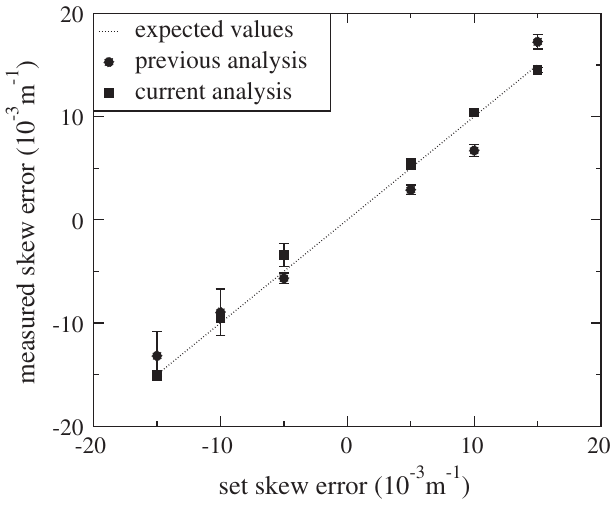
FIG. 14. Skew quadrupole errors estimated from the conven- tional difference orbits (circles) and skew quadrupole errors estimated from the new difference orbits (squares). This figure was taken from Ref. [18].